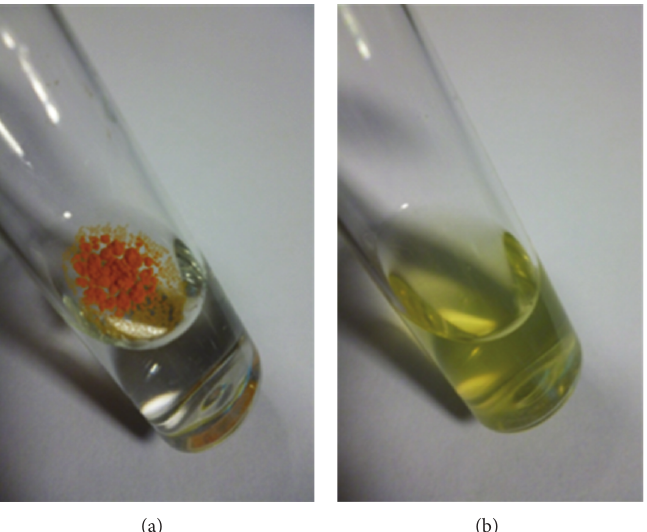
Figure 1: Photographic images of (a) free curcumin which were poorly soluble in aqueous media and macroscopic flakes can be seen floating in the bottle, and (b) curcumin loaded starch nanoparticles were fully dispersible in aqueous media.